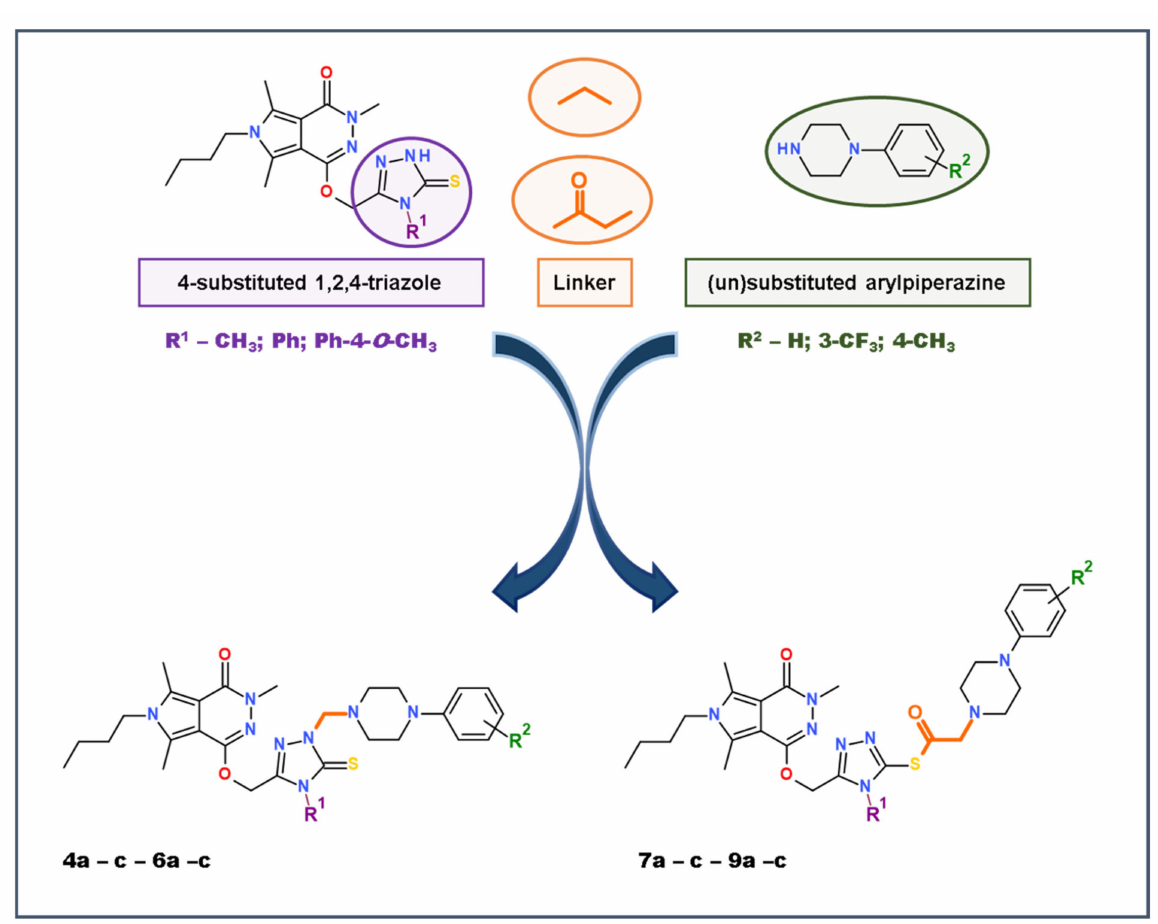
Figure 7. The concept of design and synthesis of target N -substituted-1,2,4-triazole-based derivatives of pyrrolo[3,4- d